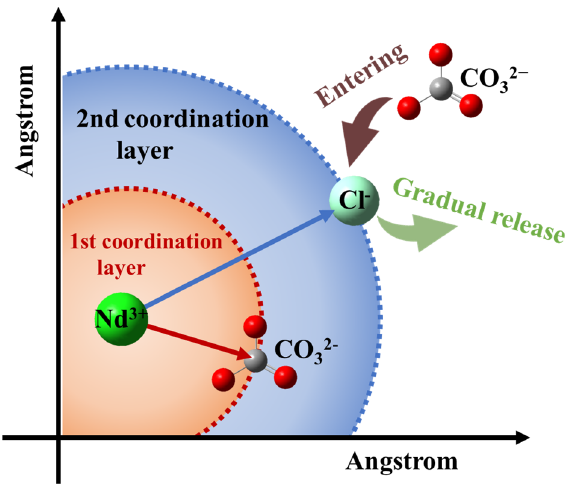
Figure 7. Coordination process of Nd 3+ in the NaCl/Na 2 CO 3 mixed electrolyte solution.